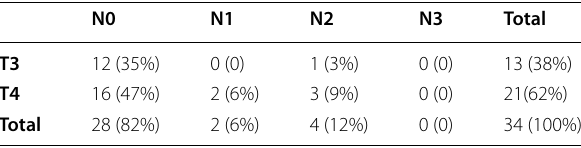
Table 1 Distribution of stage of disease by treatment Table 2 Relationship between nodal metastases and T.L.